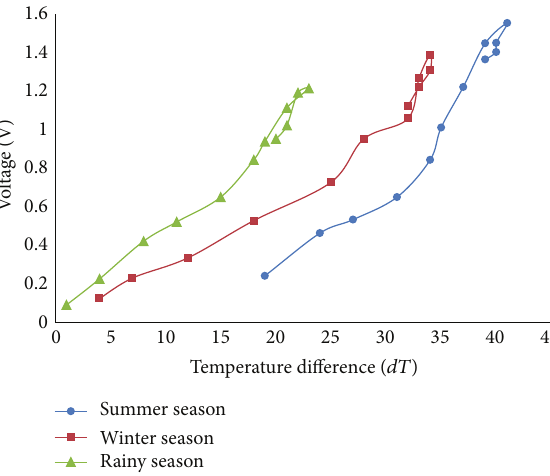
Figure 7: A comparison of temperature difference versus voltage in the duration of 2.00–4.00 pm by using thermoelectric